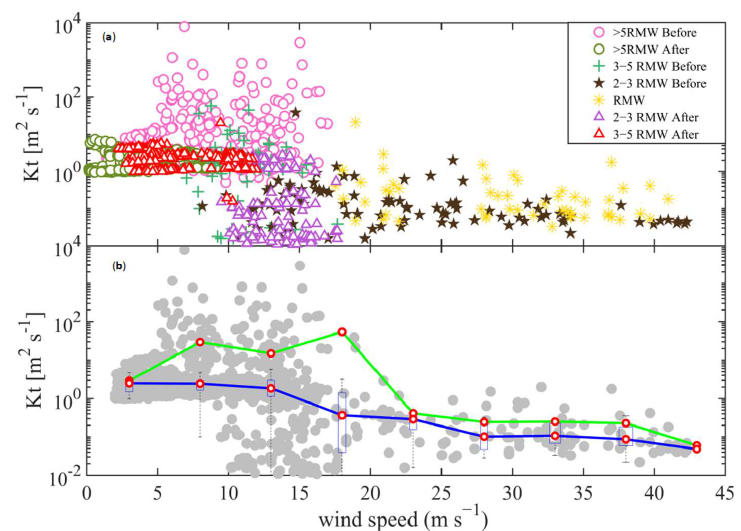
Figure 12. Vertical eddy diffusivity of heat ( K t ) as a function of wind speed ( u n ). The blue line with red circles is the bin median average K t at 5 m s –1 intervals of u n from the observations. The yellow line with the red circle represents the bin mean averaged K t with 5 m s −1 interval of u n from the observations ( a ). The data were classified into seven categories according to their distance from the typhoon center ( b ).